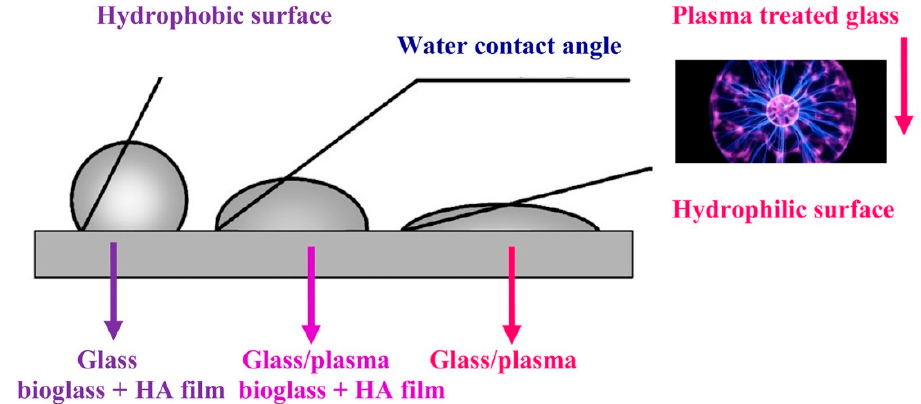
Figure 5. The schematic illustration of the surface wettability changes before and after plasma treatment. Reproduced with permission from Reference [78] . Reproduced with permission from Reference